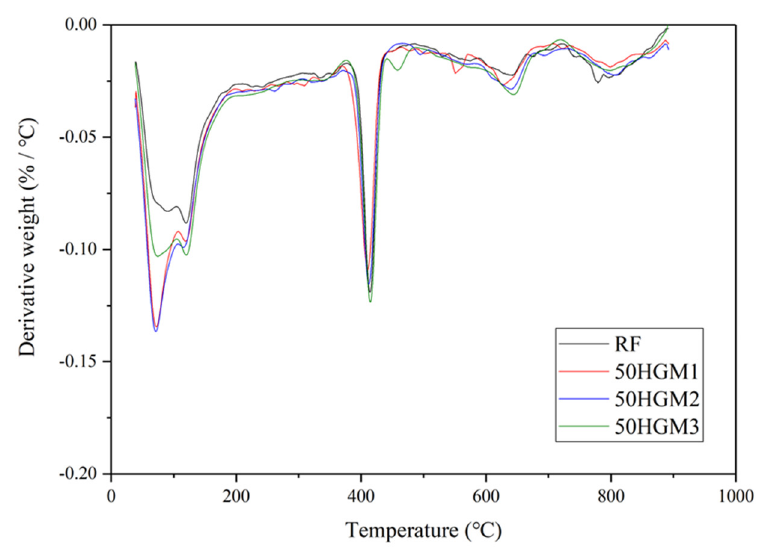
Figure 11. TGA results for specimens at a 50% replacement ratio with different HGMs.